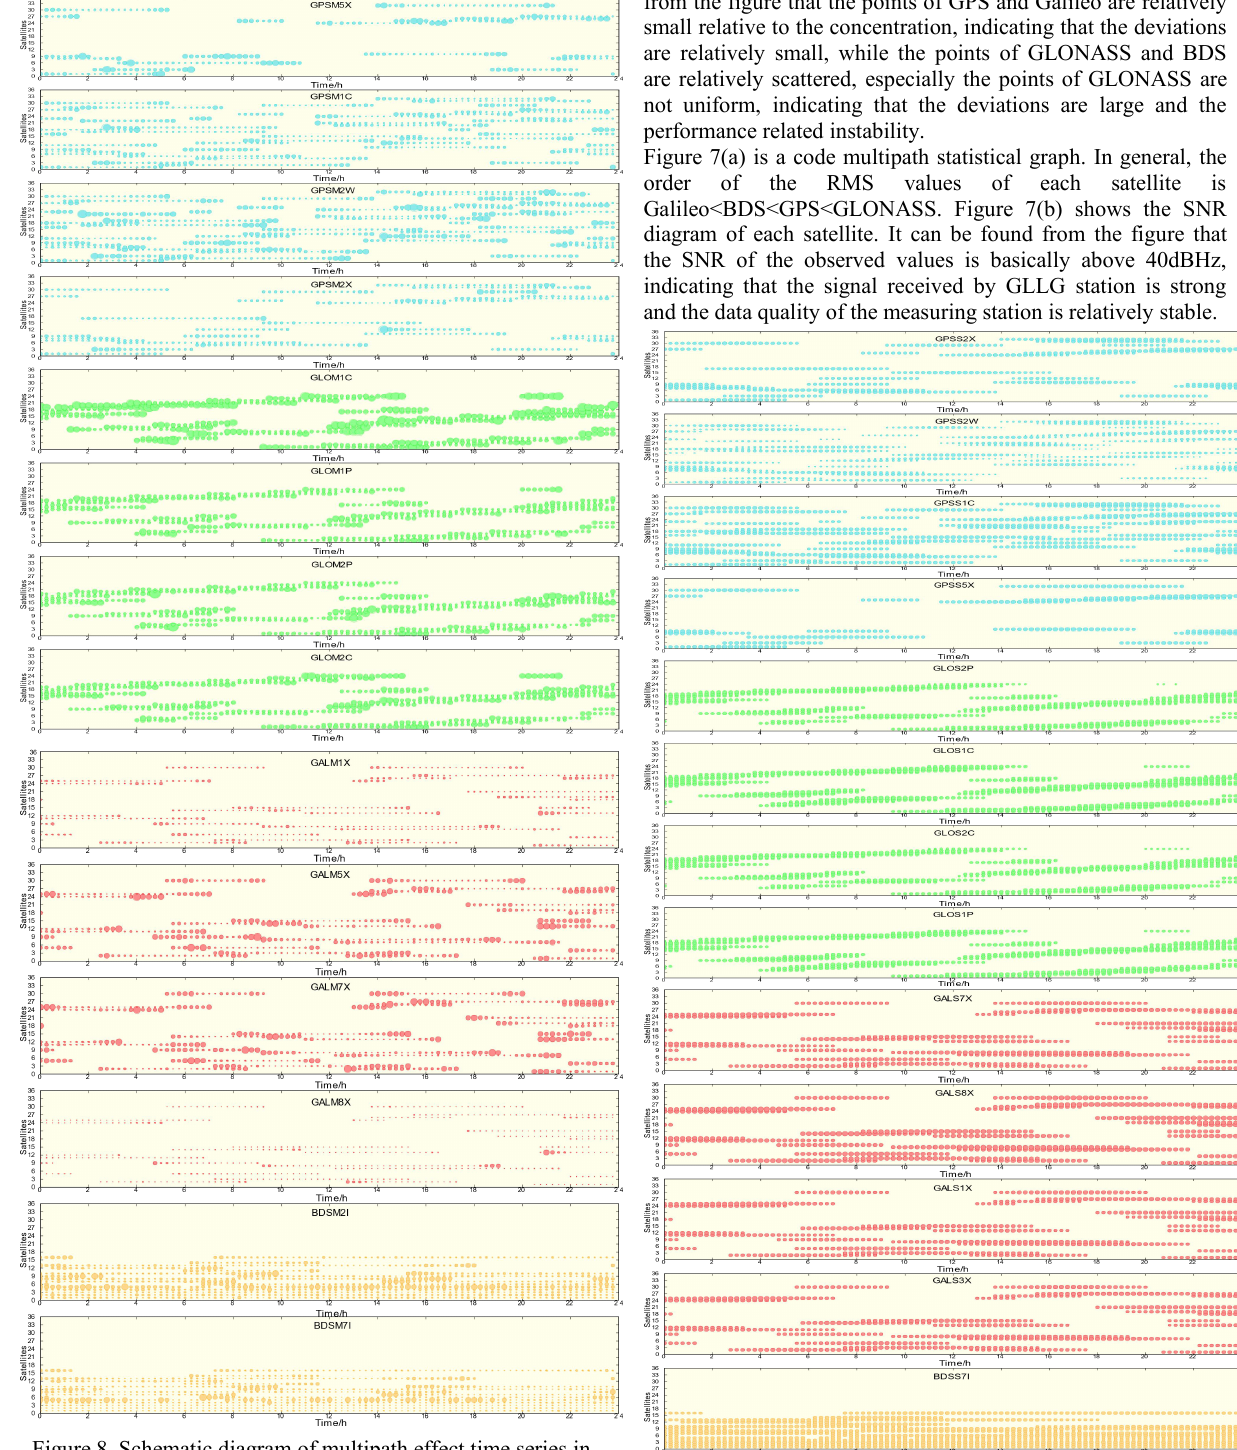
Figure 8. Schematic diagram of multipath effect time series in different bands